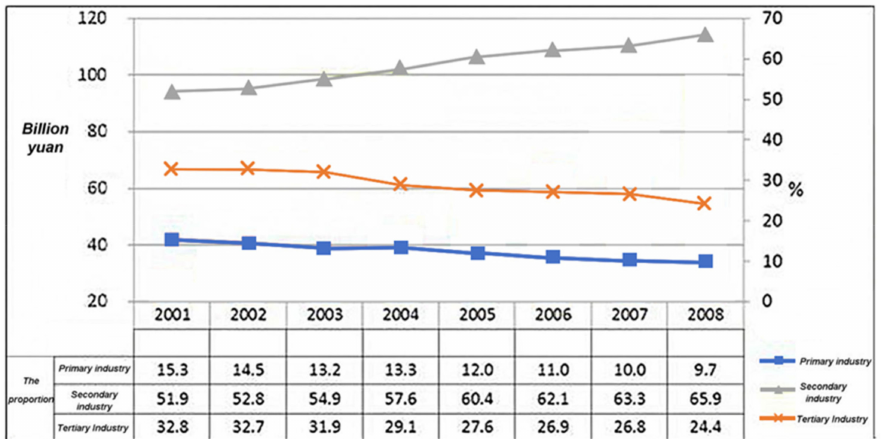
Figure 3. Changes in GDP and Industrial Structure from 2001 to